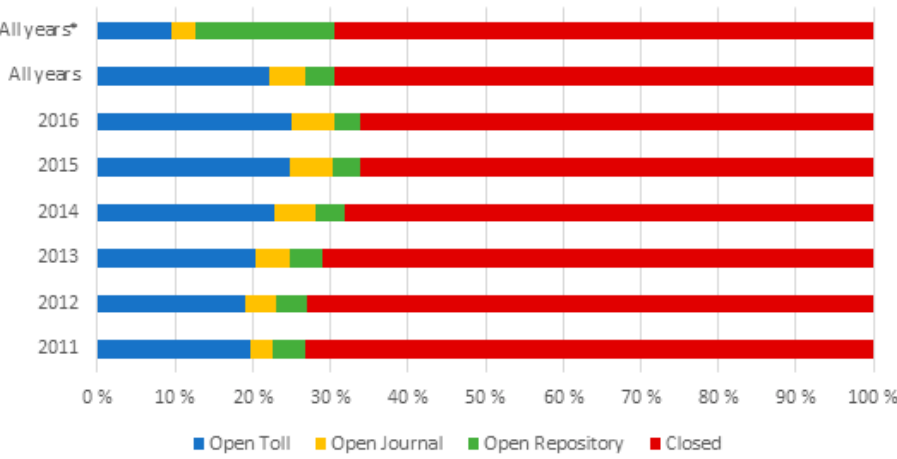
Figure 2. Open articles according to oaDOI’s Best_location, 2011–2016. The bar “All years *” reflects the total number of self-archived articles otherwise classified under Open Toll or Open Journal.